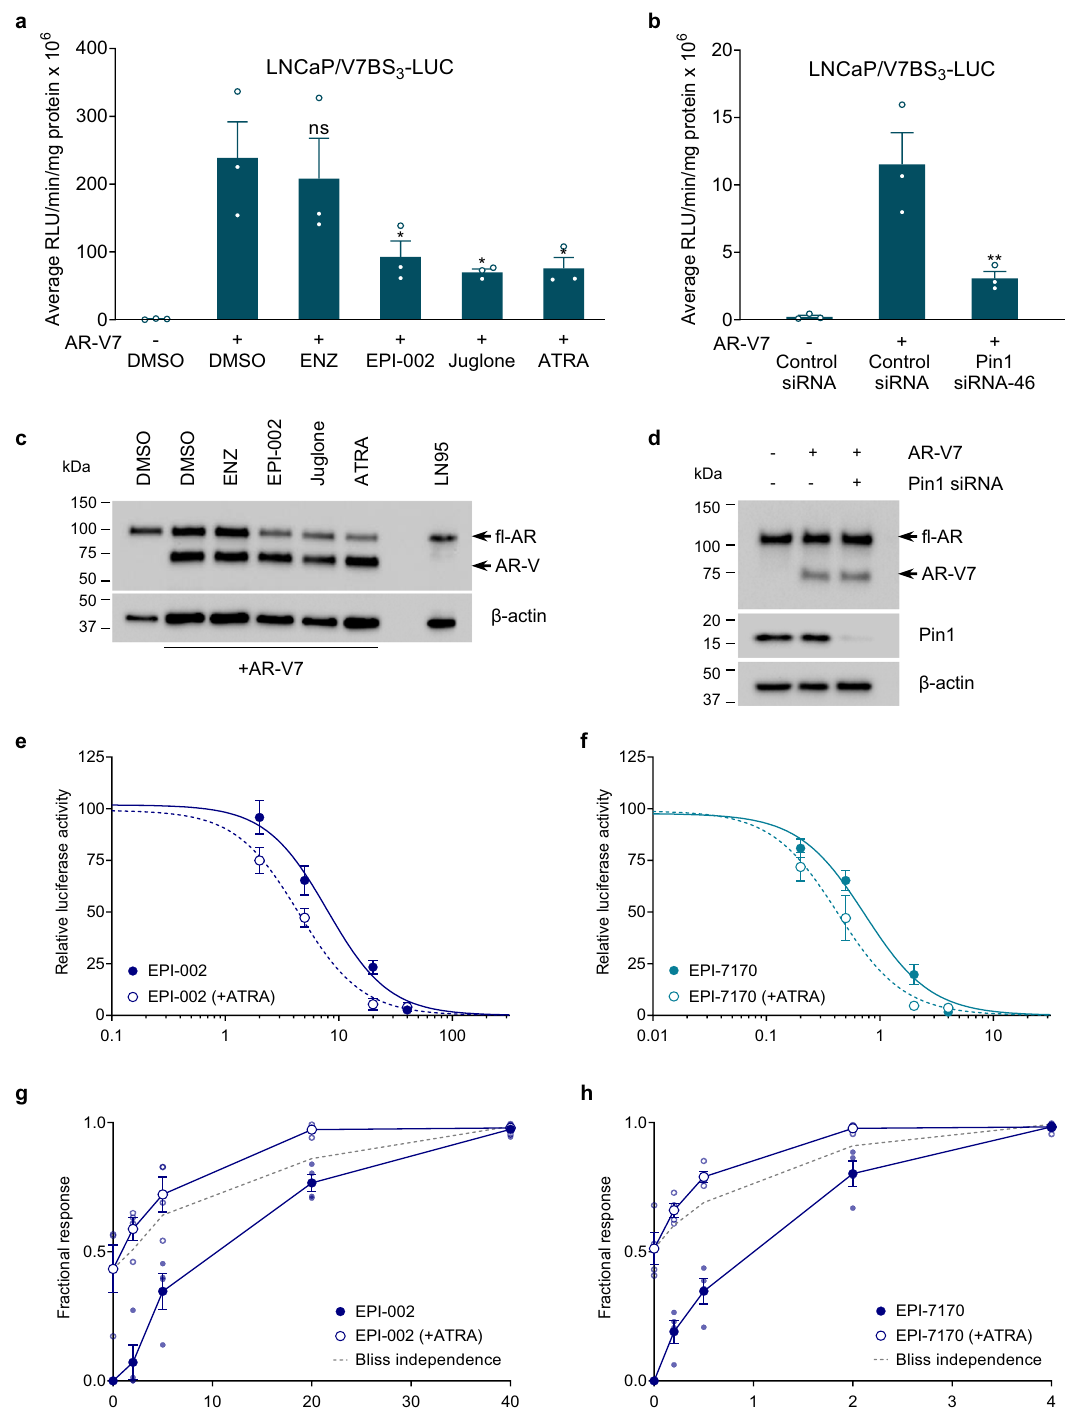
Fig. 5 ATRA enhances the inhibitory response of EPI compounds. a , b AR-V7 transcriptional activity in LNCaP cells ectopically expressing AR-V7 and transfected with a reporter regulated by AR-V7-binding sites (V7BS 3 -luciferase). Cells were incubated with a enzalutamide (10 µ M), EPI-002 (25 µ M), juglone (20 µ M), ATRA (10 µ M), or vehicle (DMSO) for 24 h, or either b Pin1 siRNA or a non-targeting control siRNA for 48 h ( n = 3 independent experiments). c , d Western blots showing the levels of ectopic AR-V7 and the ef fi ciency of the Pin1 knockdown. The inhibitory dose – response of e EPI-002 and f EPI-7170 for inhibiting the androgen-induced PSA(6.1 kb)-luciferase activity in LNCaP cells, in the presence and absence of 5 µ M of ATRA. Data shown are normalized to the fold-induction by R1881, which was approximately 82-fold at 24 h. ATRA shifted the inhibitory dose – response curves of EPI- 002 and EPI-7170 to the left, thereby lowing their IC 50 values. Graphs show the fractional responses of g EPI-002 and h EPI-7170 as monotherapies and combination therapy with 5 µ M of ATRA, compared to the predicted additive effect determined by the Bliss independence model ( n = 4). Data shown represent the means ± s.e.m. * P < 0.05, ** P < 0.01; ns not signi fi